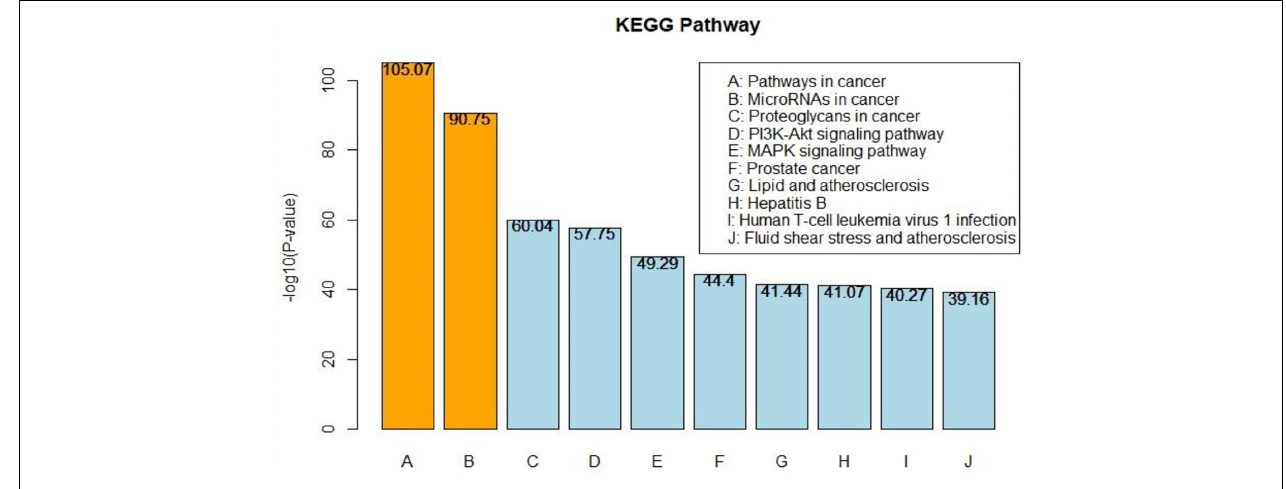
FIGURE 4 | Pathway analysis based on OC-related